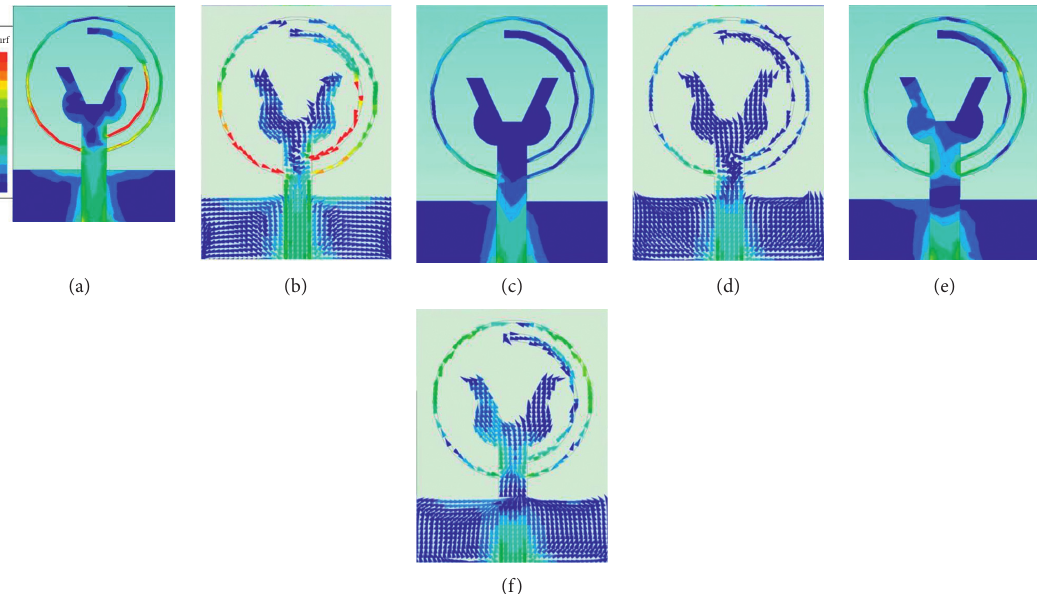
Figure 7: Simulated surface current distributions at (a) 2.4GHz, (c) 3.5GHz, and (e) 4.9GHz, and the corresponding current vector distribution at (b) 2.4GHz, (d) 3.5GHz, and (f) 4.9